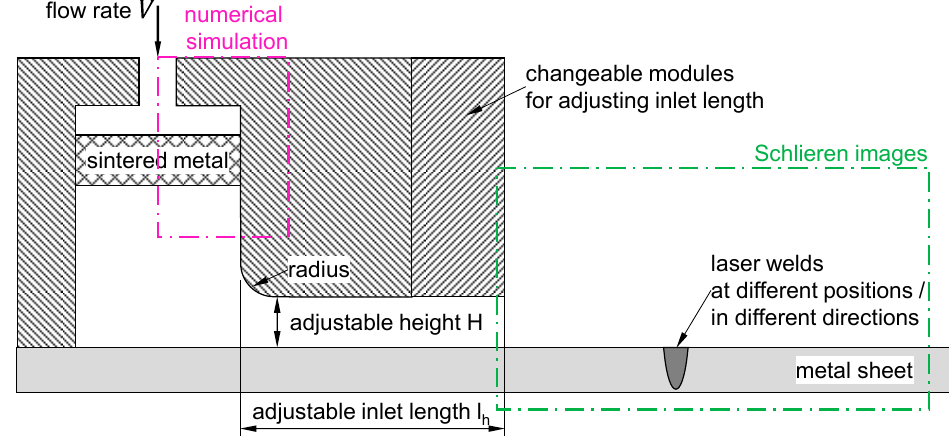
Figure 2. Schematic cross-sectional view of shielding nozzle. Two different sintered materials (see Table 1) and vanes according to [29] were con- sidered as diffusor elements. Figure 3a shows the flow velocity within the diffusor for a maximum flow rate of 32 L/min. The porous materials were positioned 20 mm below the cross-section enlargement. The realization of a homogeneous velocity profile is clearly seen by means of the false color plot. Two different sintered materials were compared by the velocity along the cutline below the sintered metal in Figure 3b. Additionally, the result of simulated vanes according to [29] was added. The sintered metals achieve a better homog- enization of the flow than vanes in a much more compact space. The homogenization of velocity flow is improved as the flowability decreases, as seen by the advantageous results of sintered metal 2 compared to sintered metal 1. This material reaches a uniform velocity distribution even in the center of the material (at diffusor width 0 in the simulation), where the highest flow velocity prevails at the inlet. Sintered metal 2 was chosen as a porous material in the diffusor (sintered bronze CA100 by GGT Gleit-Technik AG). Sufficient harmonization is provided by the presented velocity profiles to affect the flow before the gas leaves the nozzle through different inlet heights H and inlet lengths l h . Table 1. Material properties of sintered metals.